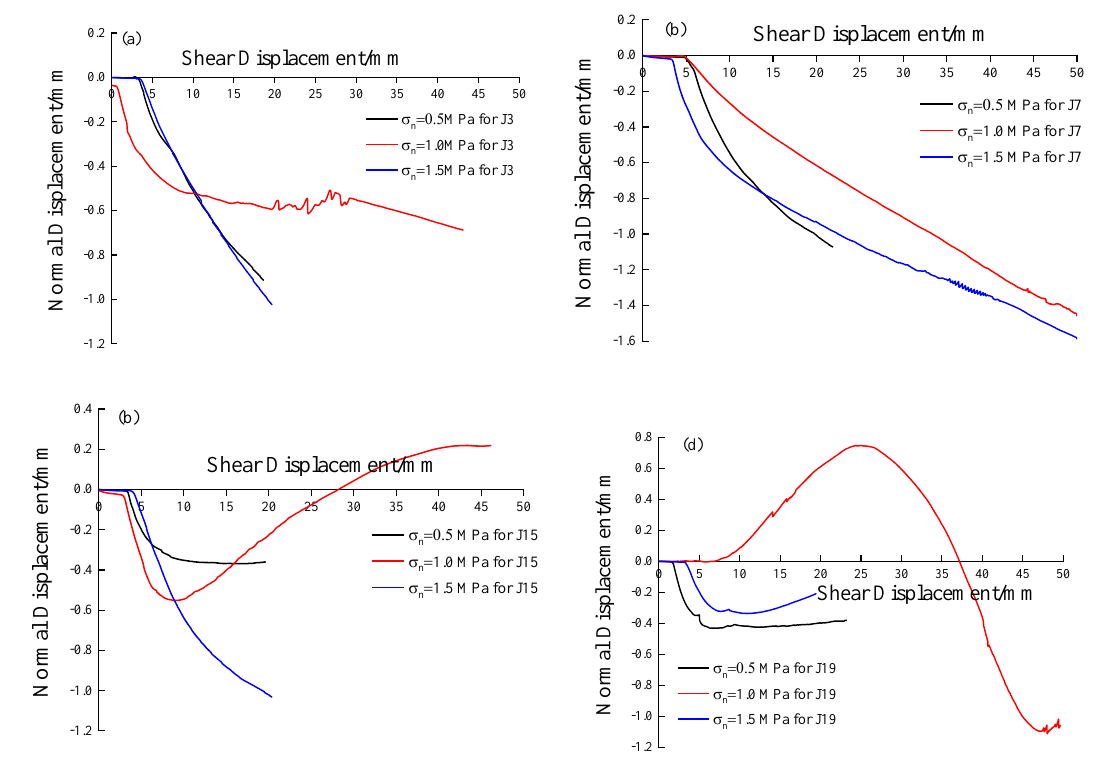
Fig.8. Normal displacement versus shear displacement curves of joints filling with semi-solid soil .